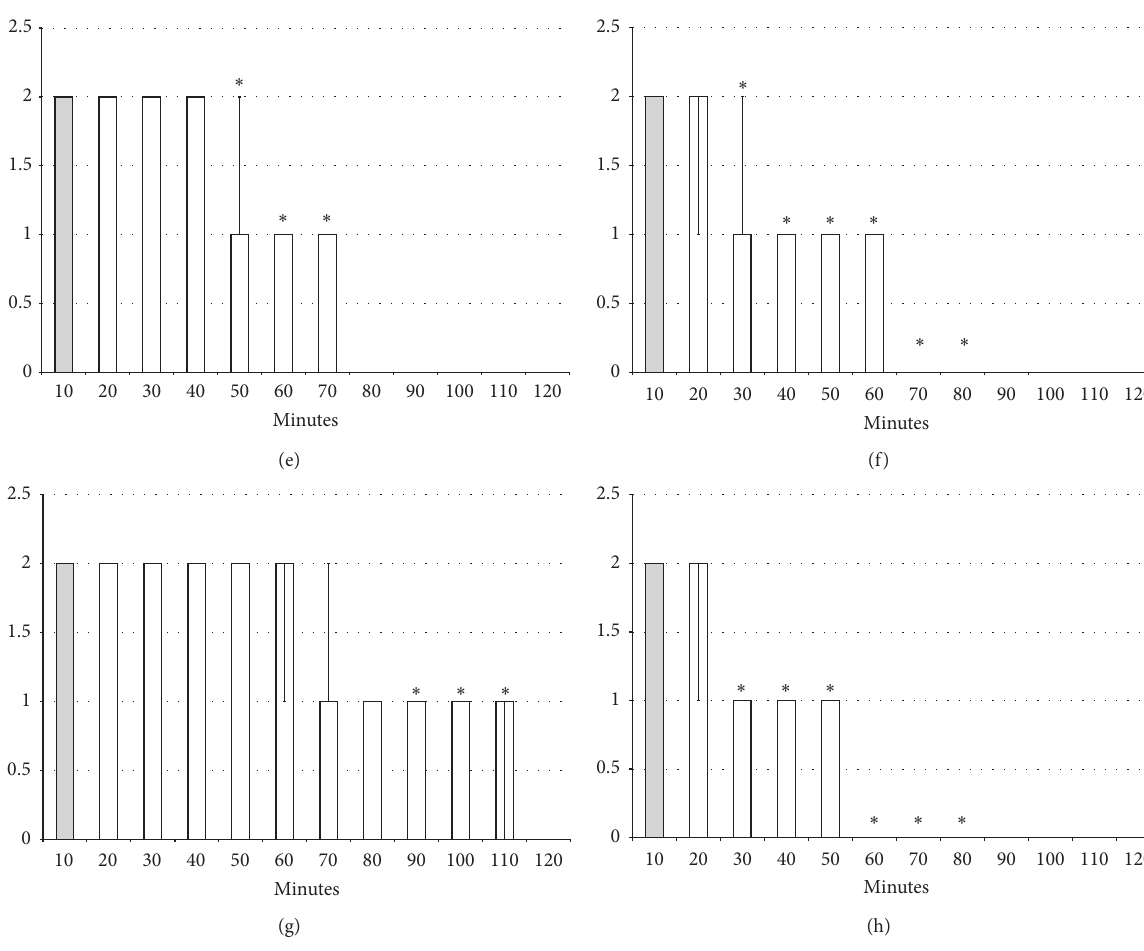
Figure 7: Axillary block (limb oedema): left brachial plexus perineural anesthesia (white bars) produced considerable fore limb oedema in the anesthetized rats. Therapy effect of the agents (saline 5 ml/kg, BPC 157 10 μ g/kg, L-NAME 5mg/kg, and L-arginine 100mg/kg in- traperitoneally, alone and/or together) given later at 10 minutes after lidocaine (gray bars indicate presentation at 10 min lidocaine-time). Fore limb oedema with perineural anesthesia of the nerves of the left brachial plexus, scored 0–3. (a) Saline (control). (b) L-NAME+L- arginine. (c) BPC 157. (d) L-arginine+BPC 157. (e) L-NAME. (f) L-NAME+BPC 157. (g) L-arginine. (h) L-NAME+L-arginine +BPC 157. Values are presented as min/med/max. ∗ P < 0 . 05 at least vs.